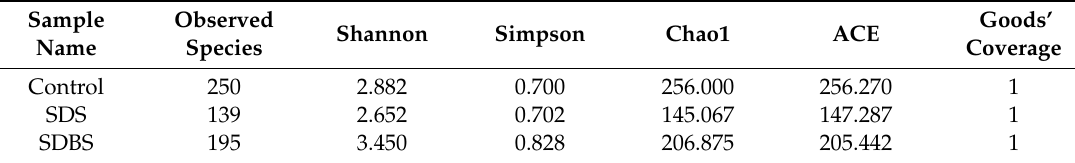
Table 1. Alpha index of three activated sludge samples with the addition of